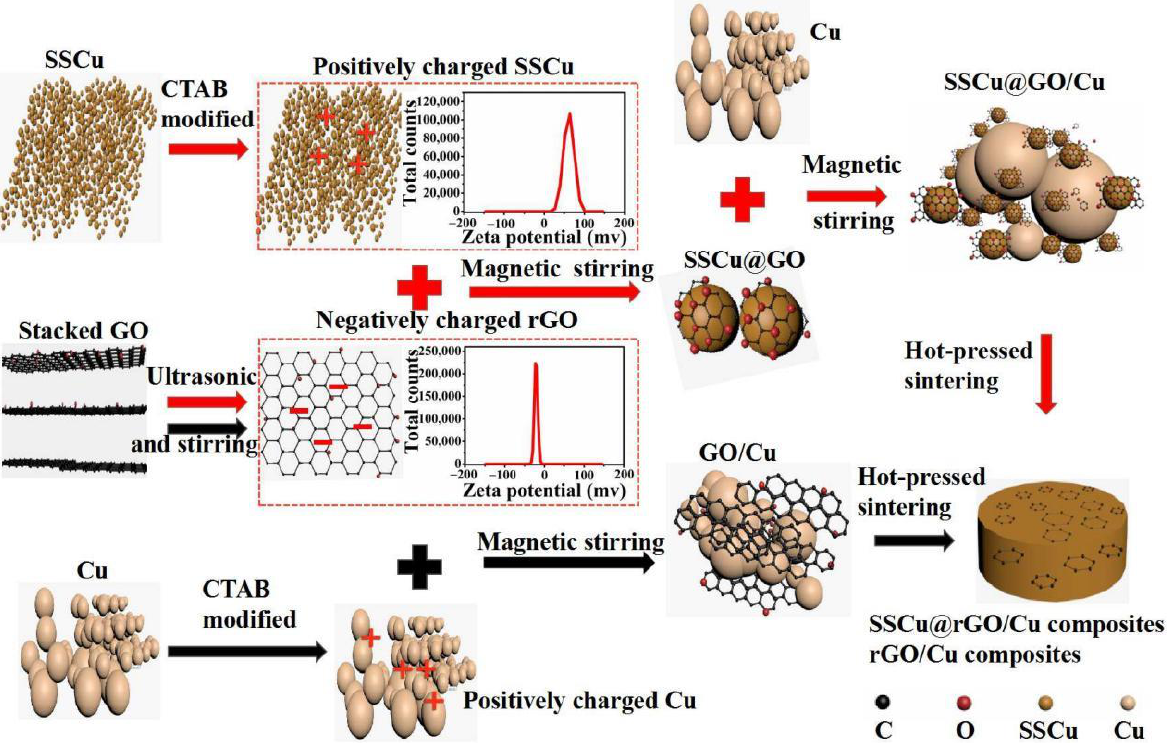
Figure 1. Schematic diagram of the preparation process of the SSCu@rGO/Cu and rGO/Cu composites.